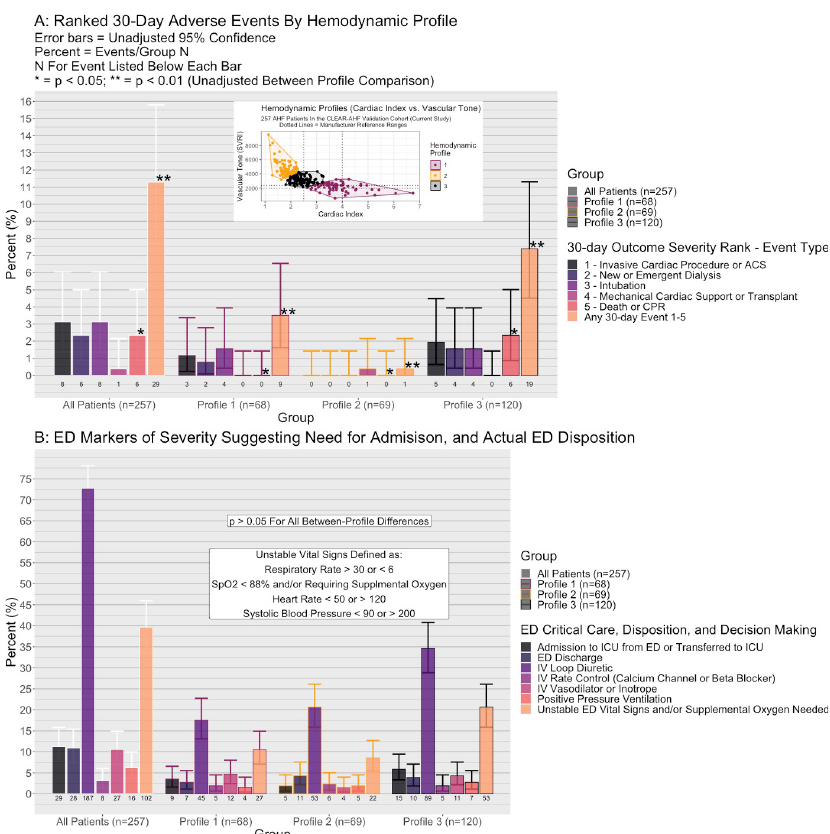
Fig 3. Comparison of cardiac index vs. vascular tone hemodynamic profiles by 30-day adverse events, emergency department (ED) characteristics, and ED disposition. (A) Hemodynamic profiles 1–3 in the validation cohort (inset) are compared by individual components of the composite 30-day secondary outcome. Compared to profile 2 (gold in inset), profile 3 (black) and profile 1 (purple) had greater rates of any outcome in the composite. (B) The were no statistically significant differences between profiles in actual ED disposition decisions (ICU, or discharge from ED), ED treatments administered, or the presence of unstable vital signs or need for supplemental oxygen.